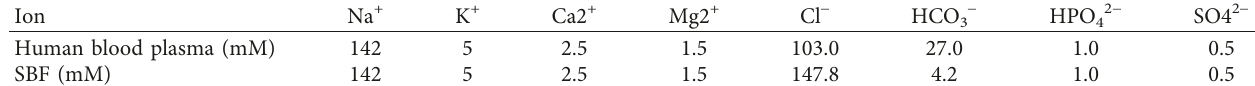
Table 1: Ionic composition of human blood plasma and SBF